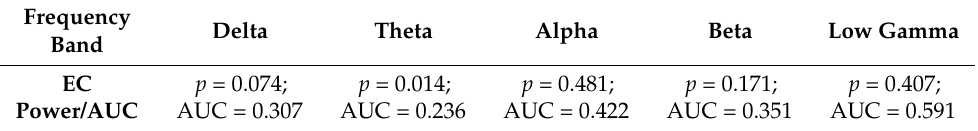
Table 5. Power and AUC comparing patients—controls at EC condition (values not corrected for multiple